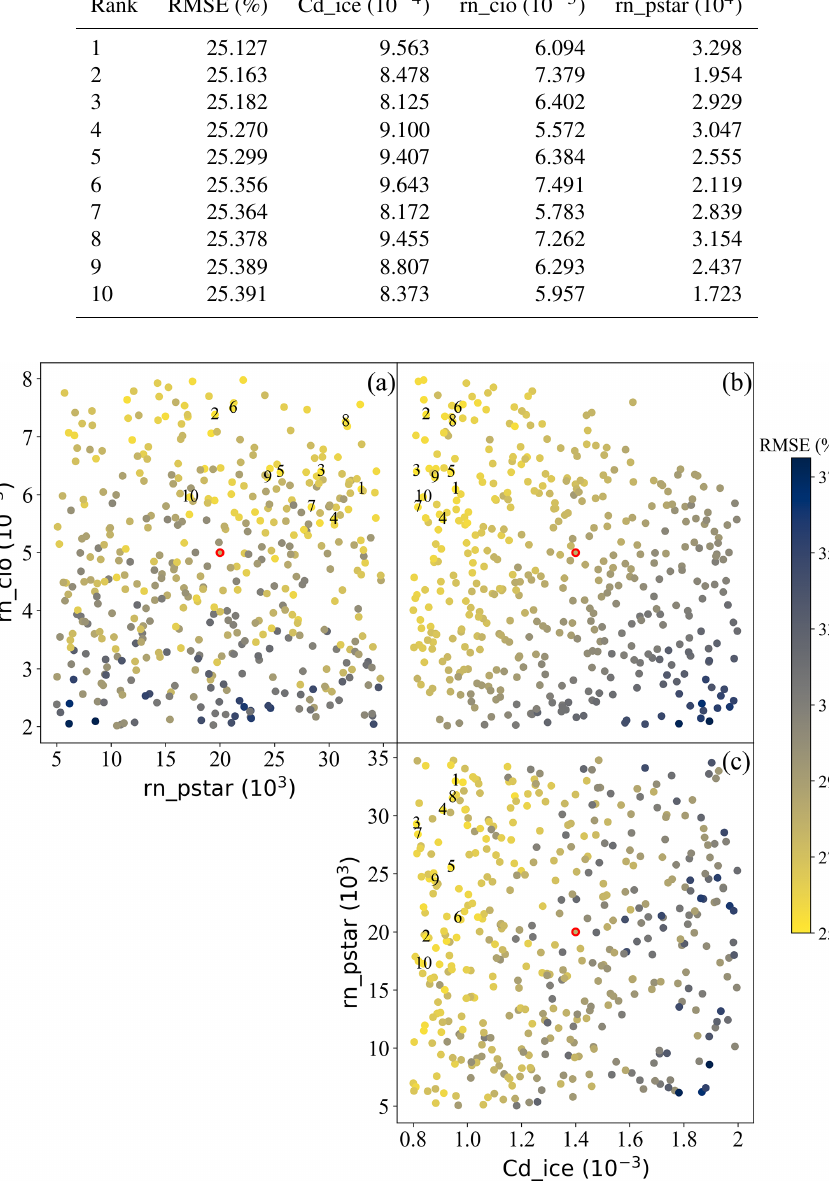
Figure 10. Average RMSE SICB for all four SIC budget components for different combinations of key parameters. The numbers 1 to 10 indicate the results of the 10 best parameter sets in ascending order of the average RMSE SICB , and the points with red edges indicate the standard values used for the CTRL